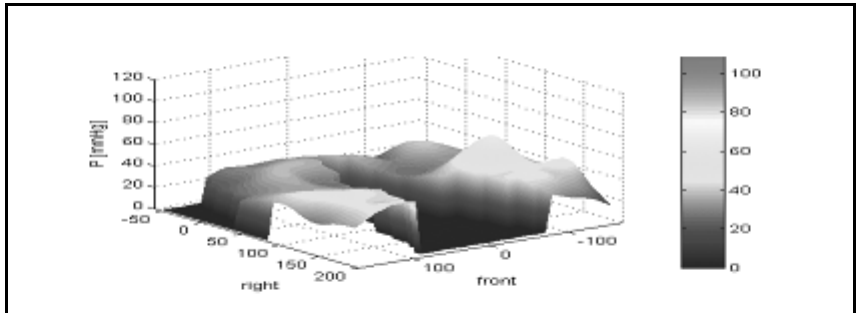
Figure 12: Dry Flotation Air cushion: Diagonally Forward leaning